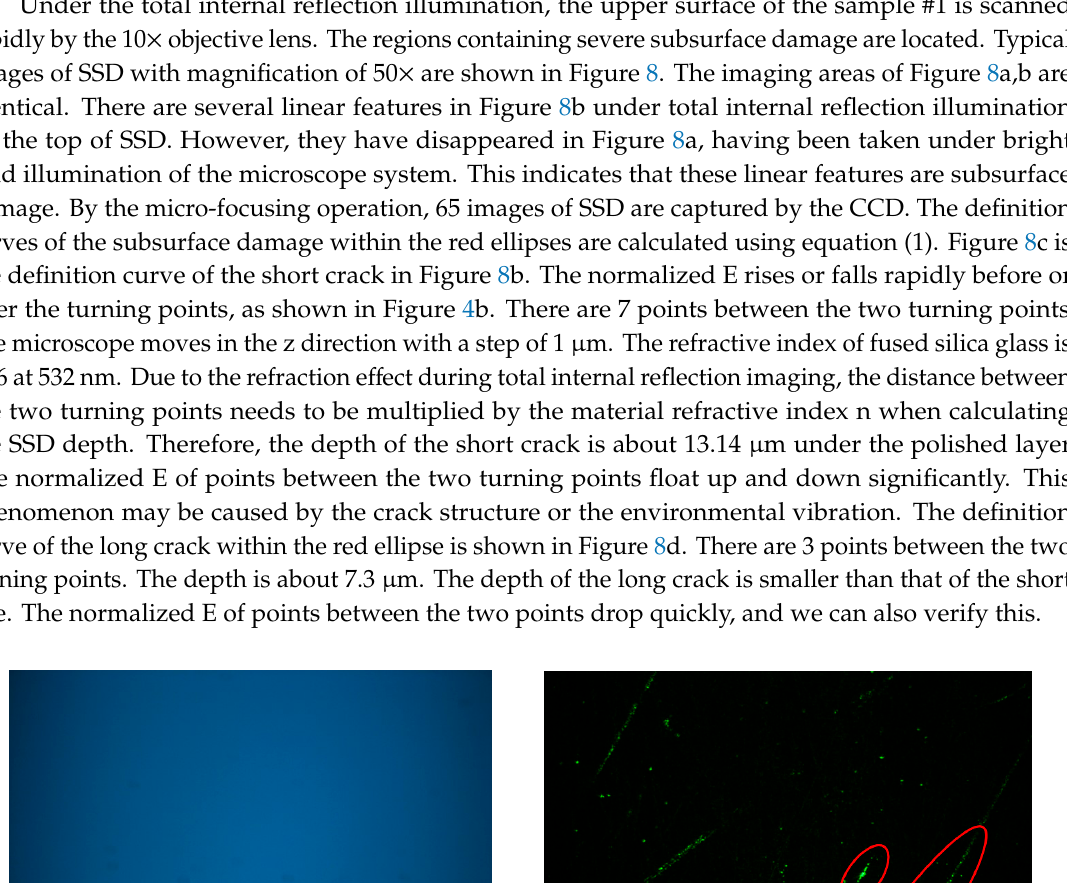
Figure 7. Photograph of our improved TIRM.